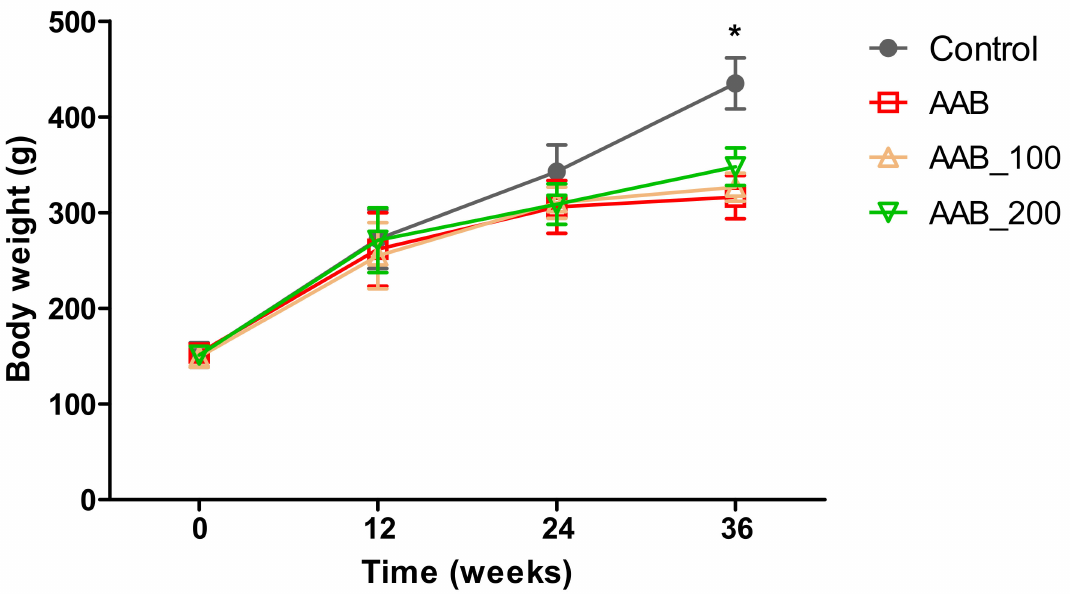
Figure 1. Evolution of rats’ body weight during the experiment. * p < 0.01 control vs AAB groups.